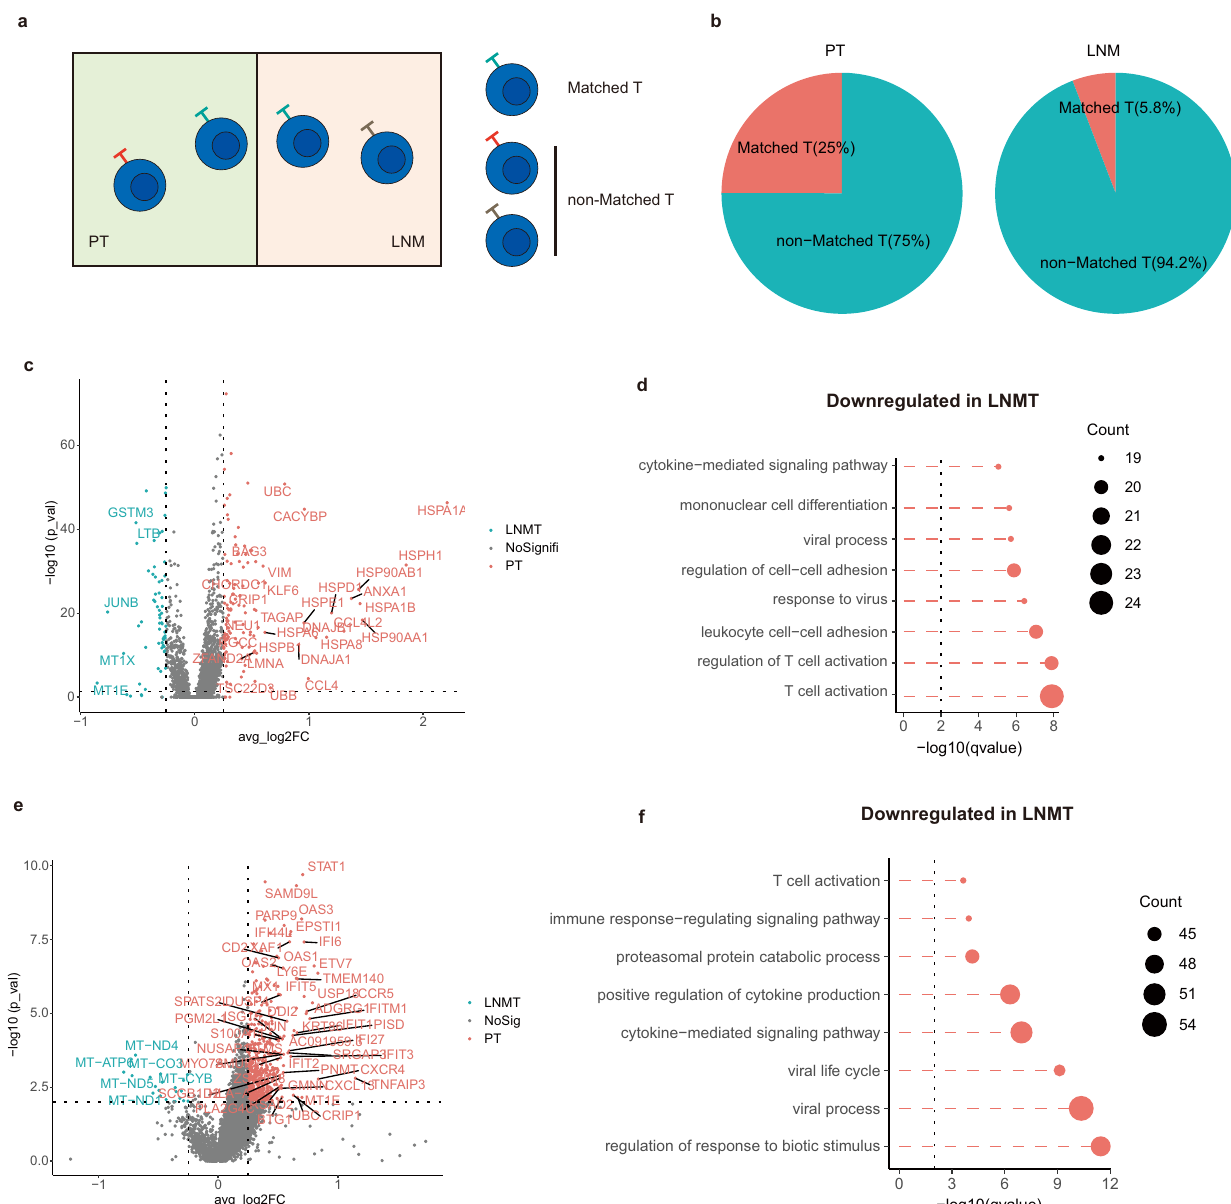
performedbyhypergeometrictest. e Volcanoplotshowingdifferentiallyexpressed genes between LNMT vs PT for matched Tconvs. P value<0.05, log2 (fold change) ≥ 0.25. Statistical testing was performed by a two-sided Wilcoxon test. f Top 8 enriched pathways for down-regulated genes in LNMT vs PT. Statistical testing was performed by hypergeometric test. Source data are provided as a Source Data fi